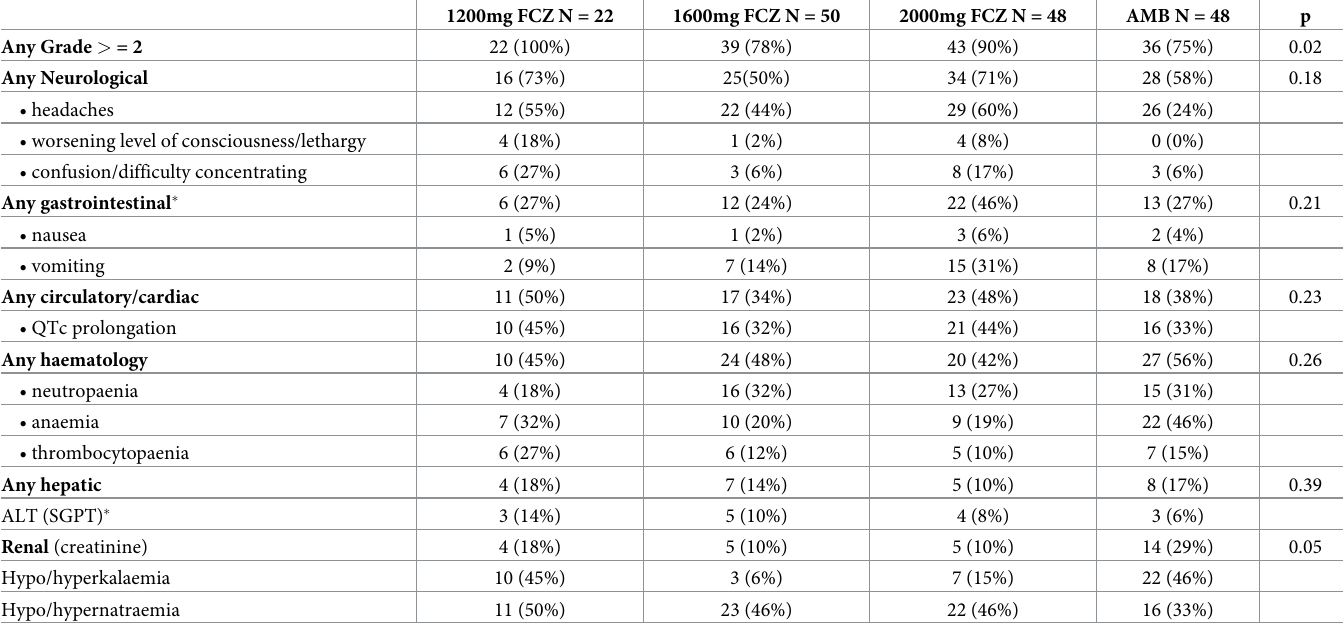
Table 7. List of grade 2 or worse adverse events through end of